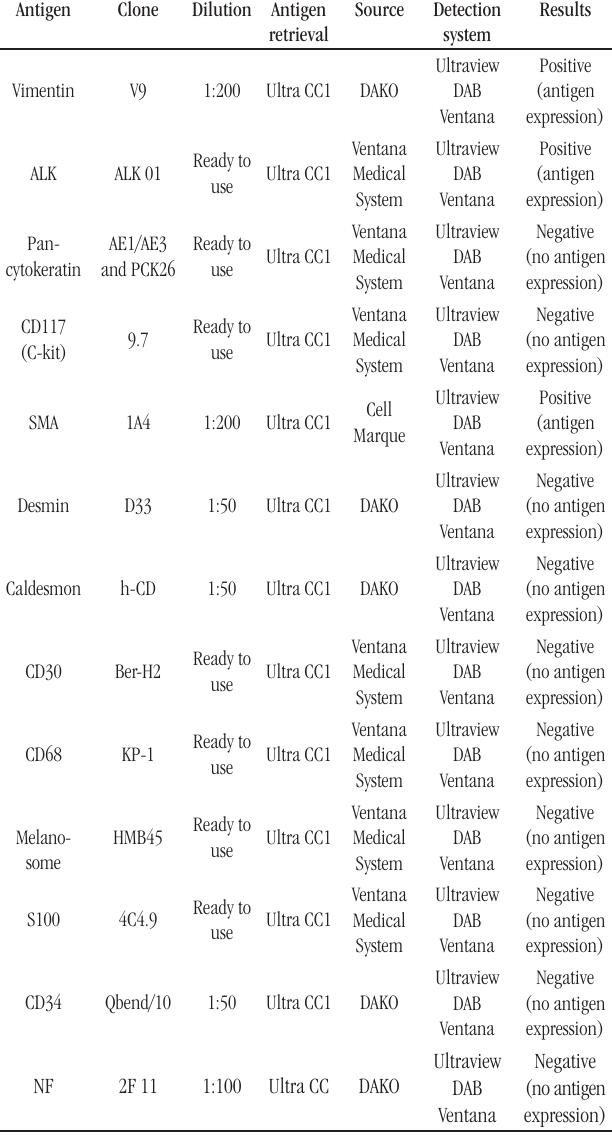
taBLE − Characteristics of antibodies used